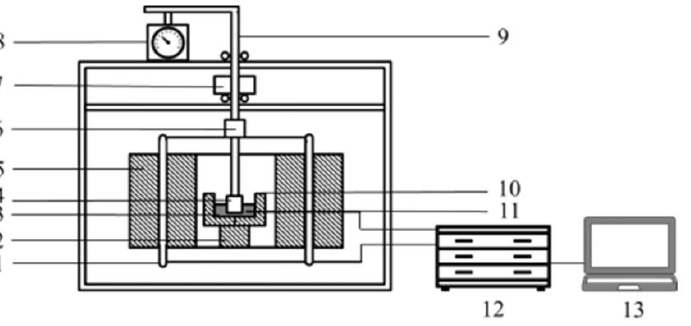
Figure 2. Schematic diagram of the softening properties experimental apparatus [9]. 1—Si-C heater; 2—shell; 3—Al 2 O 3 pedestal; 4—sample; 5-Si—C bar; 6—fastening screws; 7—load; 8—m; 9—steel bar; 10—bracket; 11—graphite crucible; 12—thermocouple; 13—temperature program controller. Table 5. Temperature and atmosphere of the softening properties test.